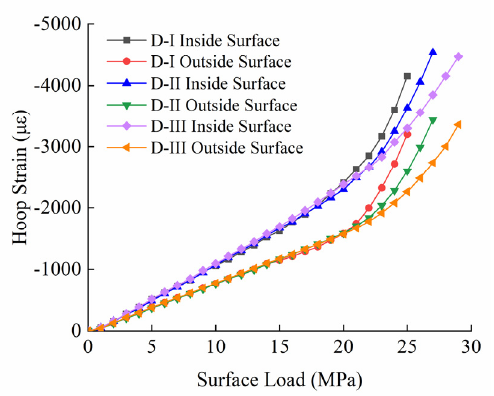
Figure 13. Relationship between hoop strain and surface loads of the shaft lining.